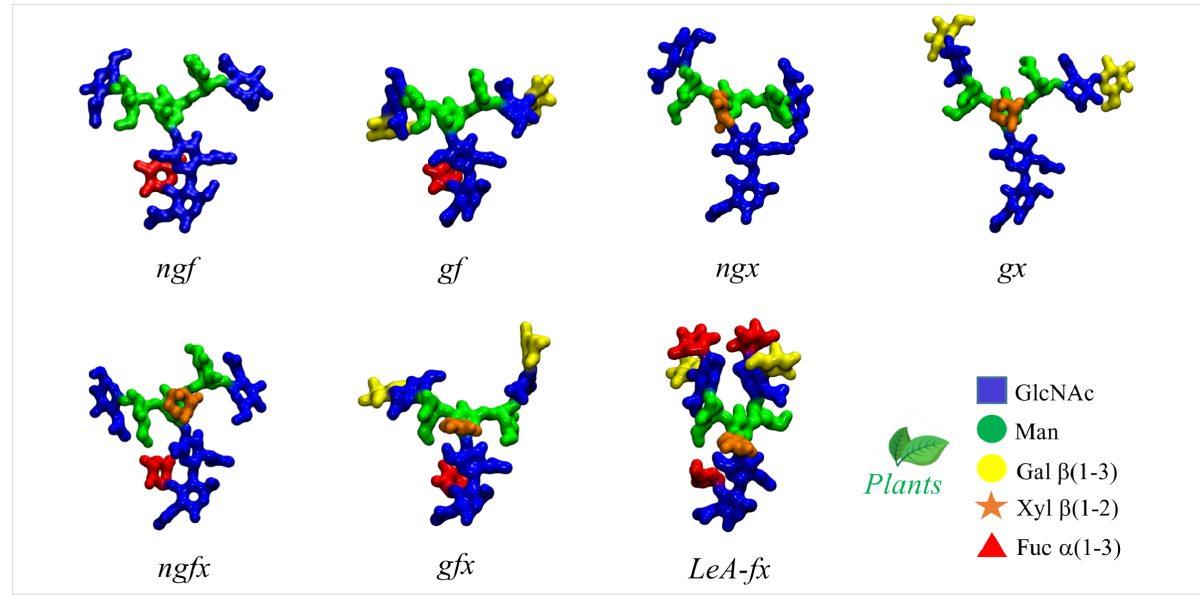
Figure 1: Representative structures of the plant N-glycans studied in this work with corresponding nomenclature. The letters f , x , and g indicate the presence of Fuc, Xyl and β (1-3) Gal, respectively, and ng the absence of β (1-3) Gal. LeA stands for Lewis A antigen. The N-glycans structures are shown with the (1-3) and (1-6) arms on the left and on the right, respectively. The monosaccharides colouring follows the SFNG nomenclature. The plants N-glycan characteristic linkages are indicated in the legend. Rendering was done with VMD